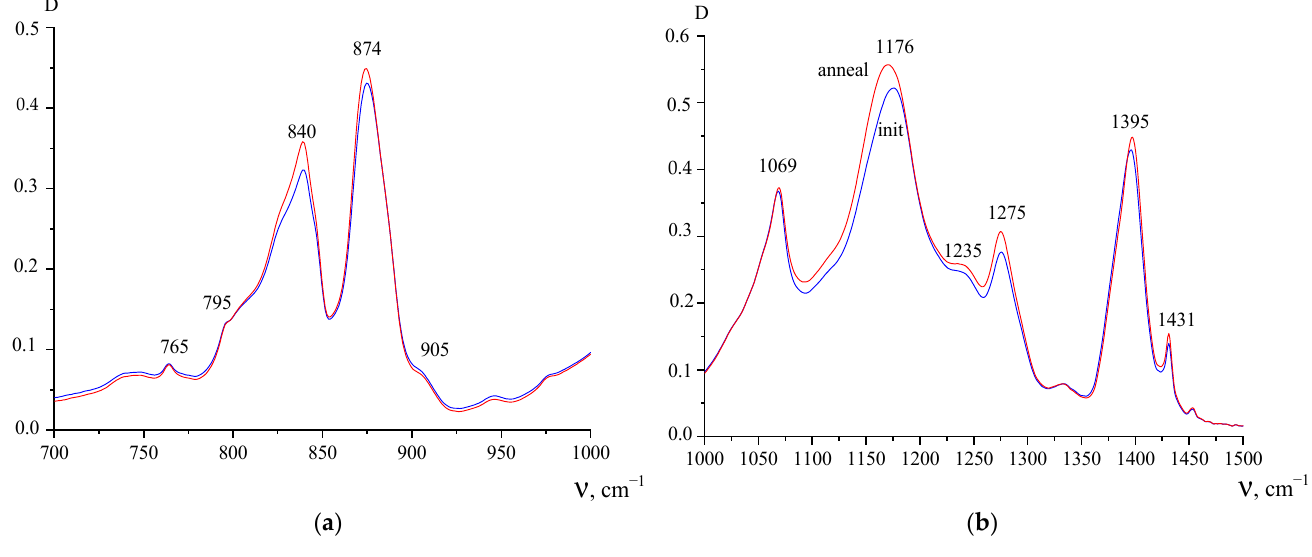
Figure 4. ATR IR absorption spectrum in the 700–1000 cm − 1 ( a ) and 1000–1500 cm − 1 ( b ) range for the original PVDF film (blue curve) and after heating to 200 ◦ C (red